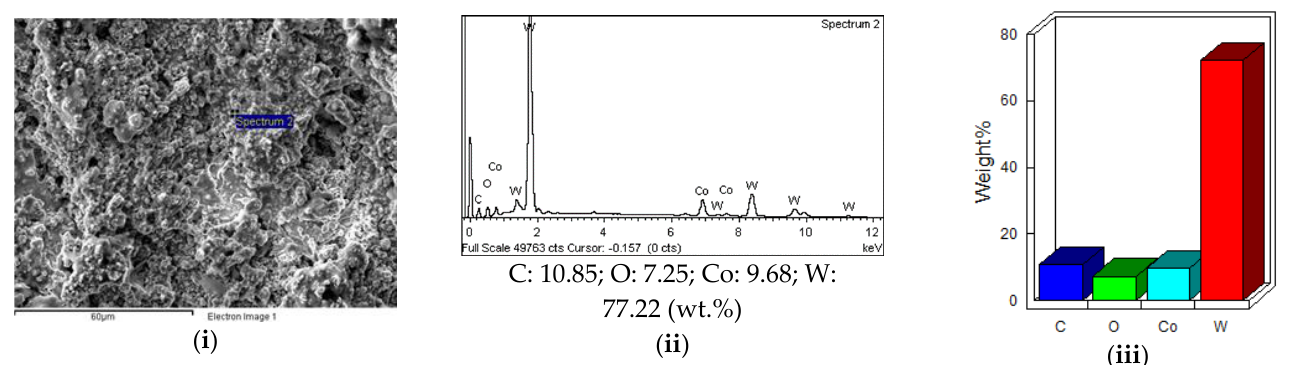
Figure 9. EDS characterization of WC-12Co coating; ( i ): microstructure; ( ii ): Element histogram; ( iii ): Quantitative EDS results.